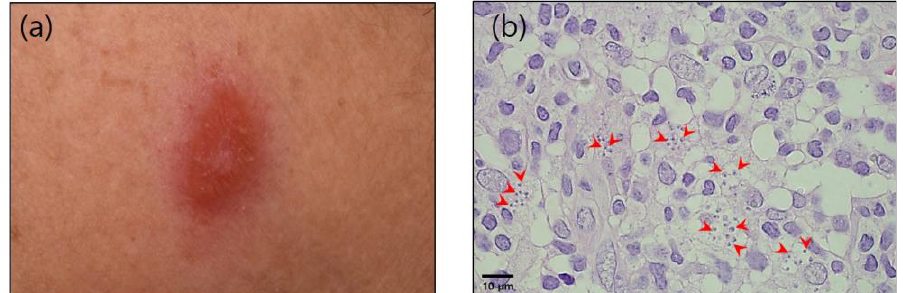
Figure 1. ( a ) Cutaneous nodular lesion caused by Leishmania infection on the left side of the patient’s chin (24 May 2021). ( b ) Microscopic appearance of skin lesions with an amastigote form of Leishmania (red arrowheads) (hematoxylin and eosin staining; 1000× magnification).